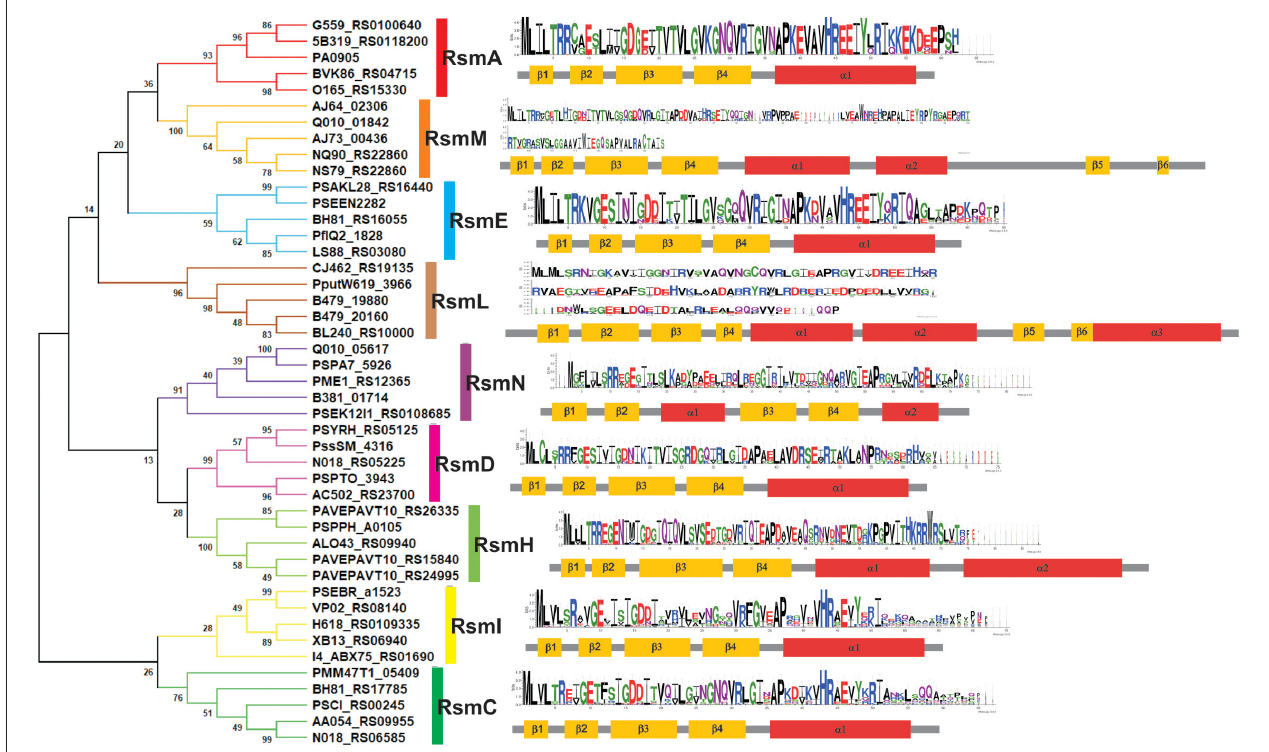
FIGURE 6 | Families of Rsm (CsrA) proteins within the genus Pseudomonas as deduced from comparative genomics. Phylogenetic relationships of the 9 subfamilies of Pseudomonas Rsm proteins. The evolutionary history was inferred using the Neighbor-Joining method ( Saitou and Nei, 1987). The optimal tree with the sum of branch length = 7.34 is shown. The percentage of replicate trees in which the associated taxa clustered together in the bootstrap test (1000 replicates) are shown next to the branches ( Felsenstein, 1985). The evolutionary distances were computed using the JTT matrix-based method (Jones et al., 1992) and are in the units of the number of amino acid substitutions per site. This analysis involved 45 amino acid sequences. For each one, the locus tag identification is presented in the figure. All positions containing gaps and missing data were eliminated (complete deletion option). There was a total of 46 positions in the final dataset. Evolutionary analyses were conducted in MEGA X (Kumar et al., 2018). Secondary structure was predicted with JPRED4 server (Drozdetskiy et al., 2015). For each Rsm subfamily, a sequence logo ( Crooks et al., 2004) was generated from multiple alignment data by MUSCLE (Edgar,